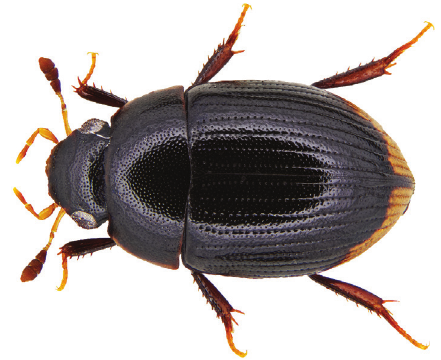
Figure 36. Cercyon dieganus Régimbart, 1903 2.6 mm, iSimangaliso Wetland Park, Eastern Shores (site 23), February 2015 DT Bilton, MS Bird & R Perissinotto leg.